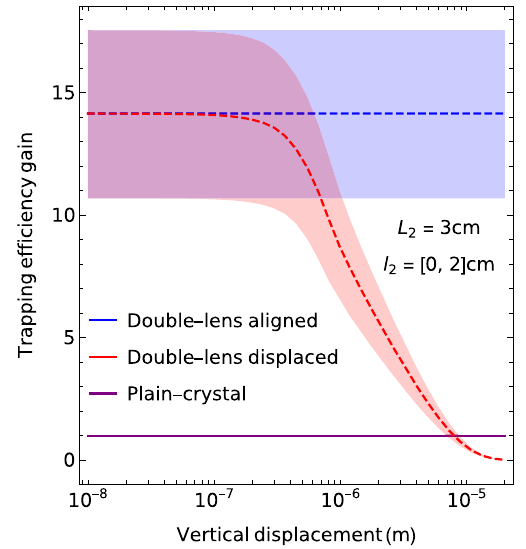
Fig. 7 Trapping efficiency with respect to the plain-crystal scheme, as a function of the vertical displacement of the two focal points, with a 2-cm target. The shaded bands represent the variation of the trapping efficiency across the crystal entry face, due to the small change on the distance to the focal point, noted as l 2 in Fig.3. The maximum extra distance is l max 2